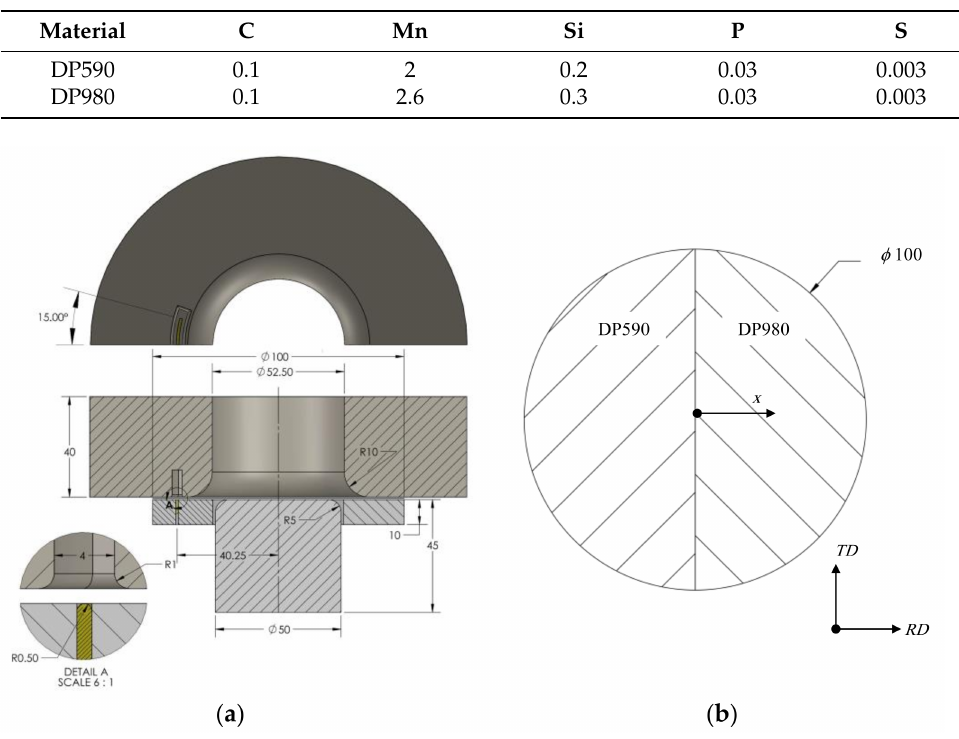
Table 1. Chemical composition of the base sheets (wt %).